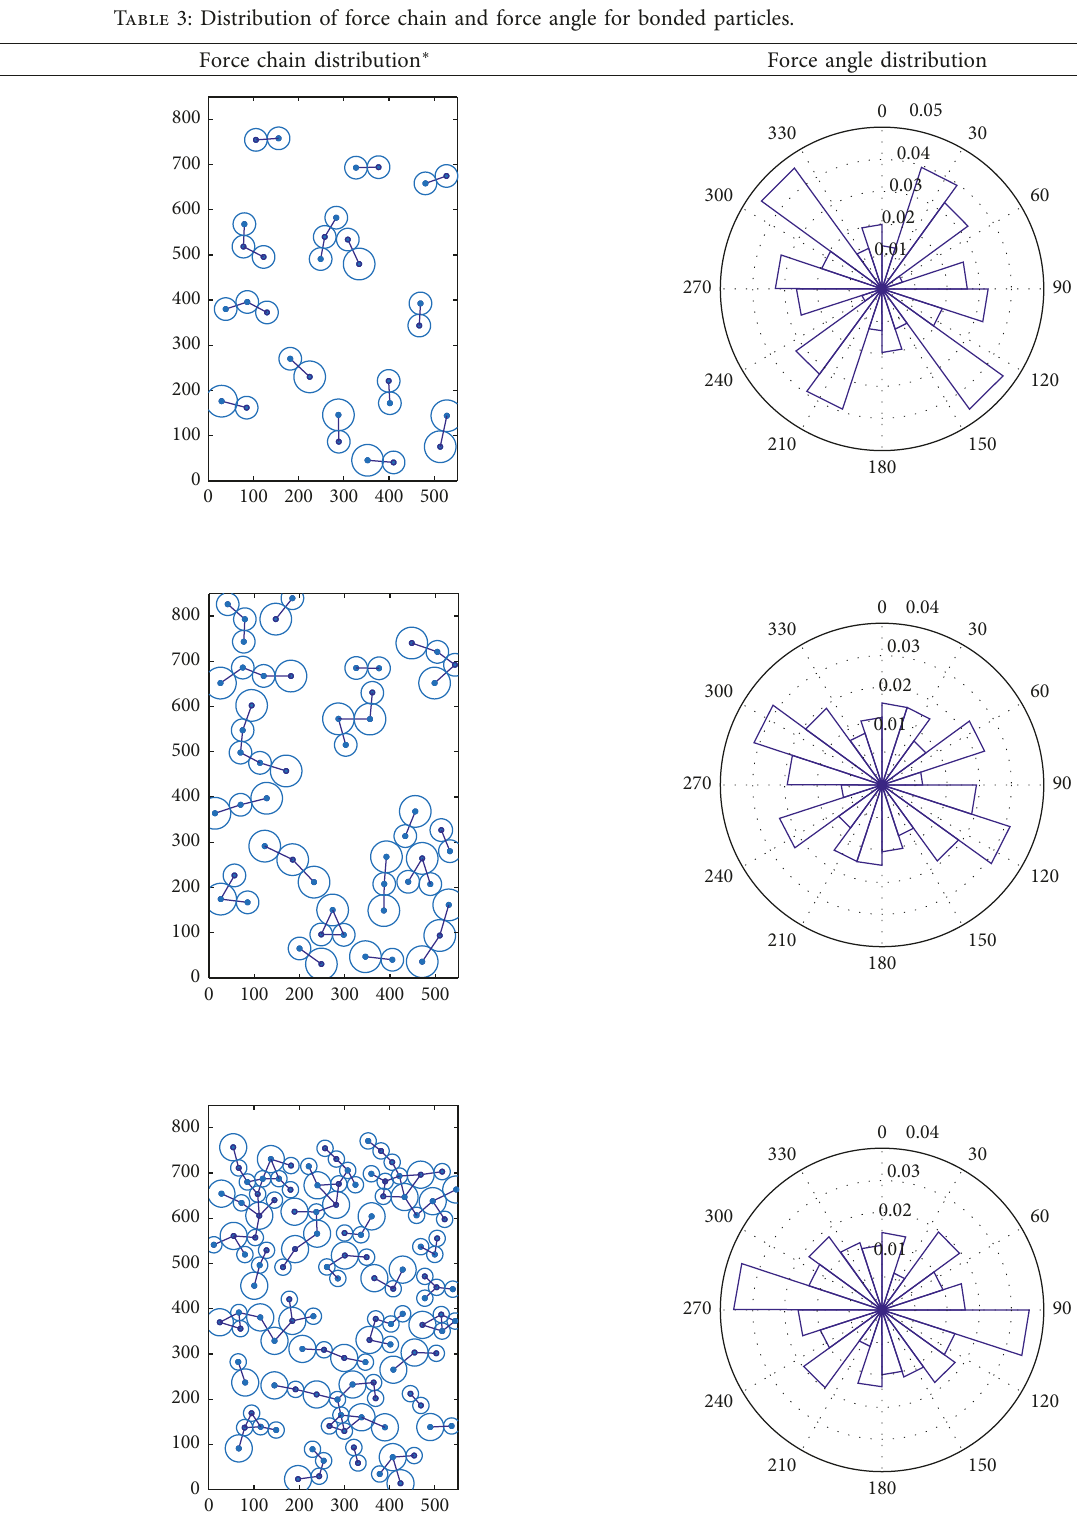
Table 3: Distribution of force chain and force angle for bonded